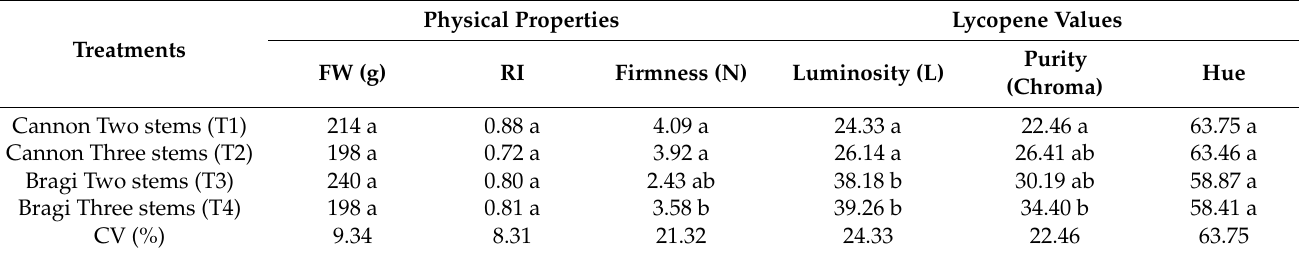
Table 2. Physical properties and color of pepper fruits for ‘Cannon’ and ‘Bragi’ cultivars in greenhouse black pepper